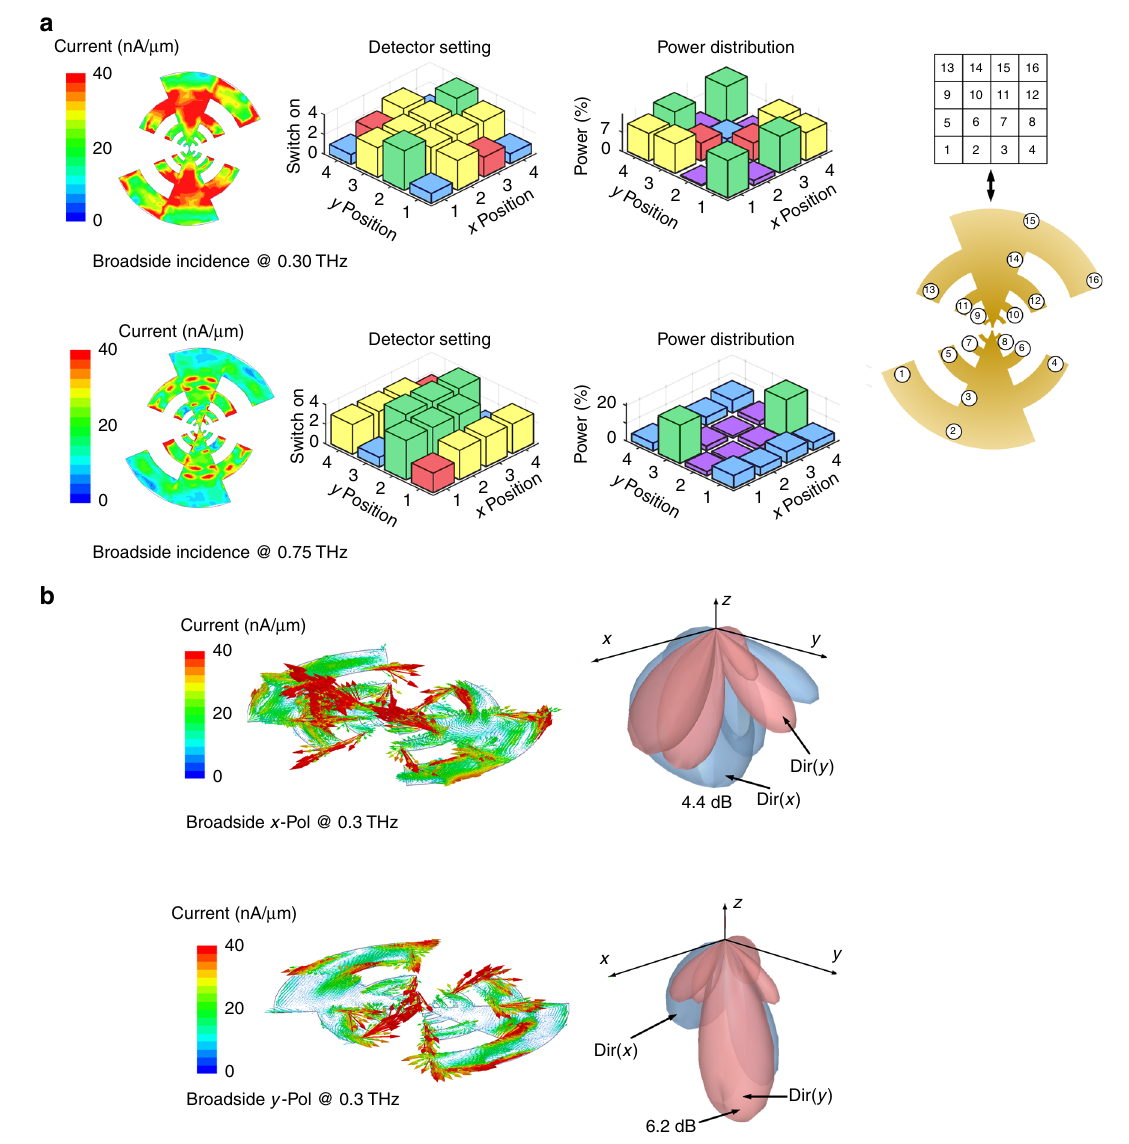
Fig. 3 Direct digital programming of the interface against spectrum and polarization. a Detector con fi gurations, power distributions and surface current con fi gurations for optimized reception at 0.3 and 0.75 THz at the broadside. The fi gure also shows the mapping of ( x , y ) position to location of the detectors on the antenna. The fi gure demonstrates that the reprogramming the surface for optimal reception at 0.75 THz can enhance responsivity by 12 times. b Simulated polarization responsivity and beam patterns when the surface is actuated against the two polarization. Programming the sensor response can enhance the reception by 16 times through polarization rotation of the surface